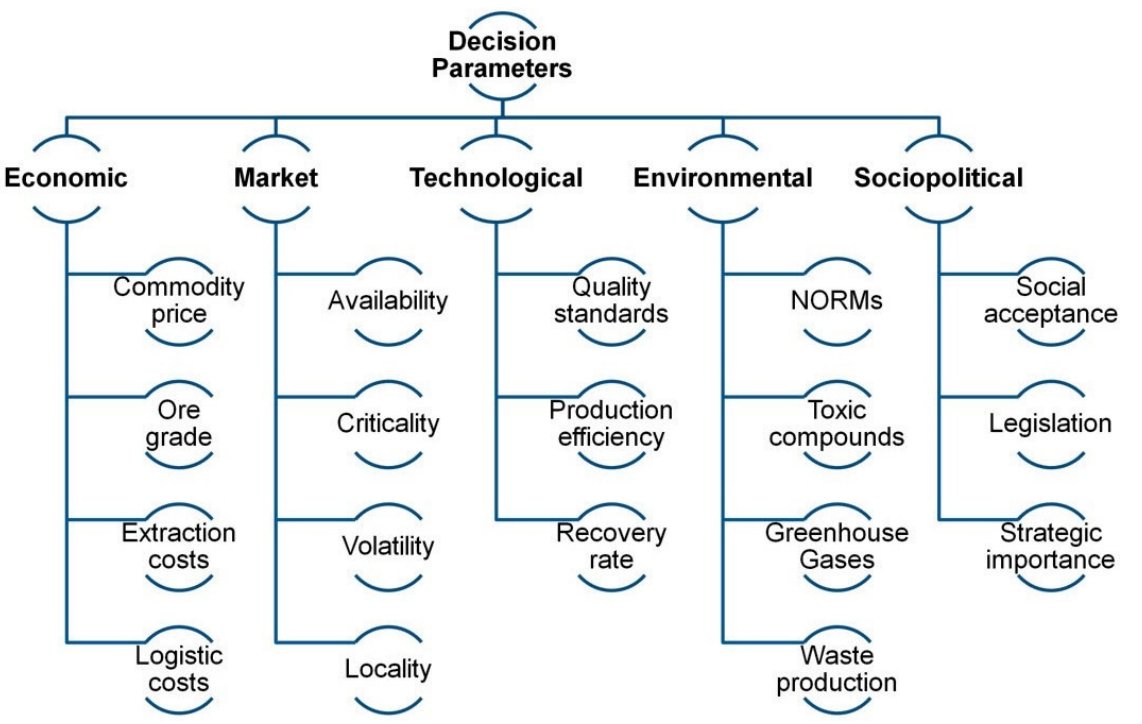
Figure 3. Classification of the parameters for the determination of co- and by-products production. The overall classification is hierarchical so that all criteria are rightfully prioritized.